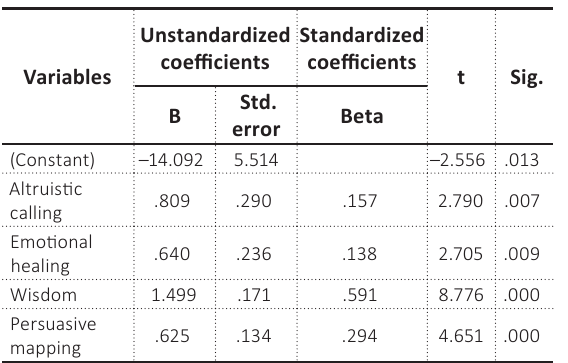
Source: Processed